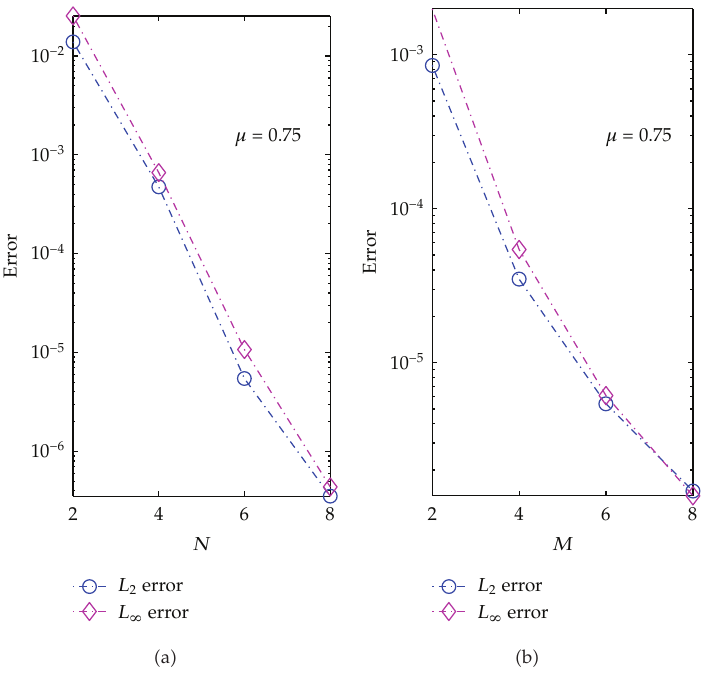
Figure 11: y -axis is log scale. (cid:4) a (cid:5) Error varying with the polynomial degree N . (cid:4) b (cid:5) Error varying with the polynomial degree M